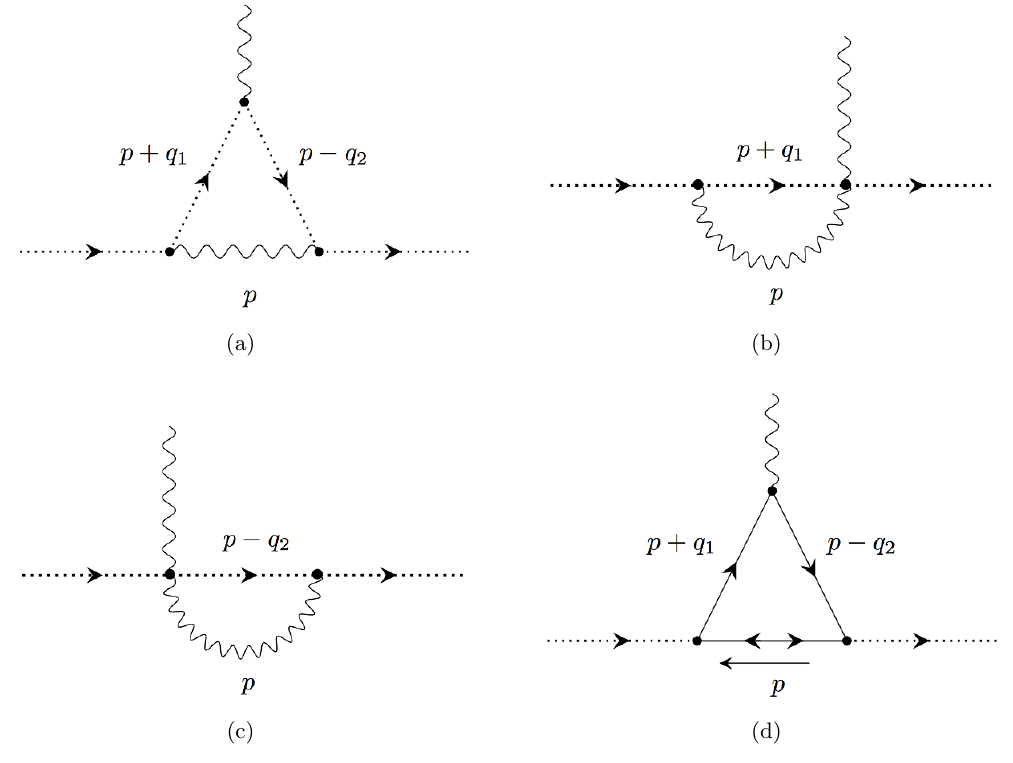
Figure 7 . The selectron charge renormalization in the N = 1